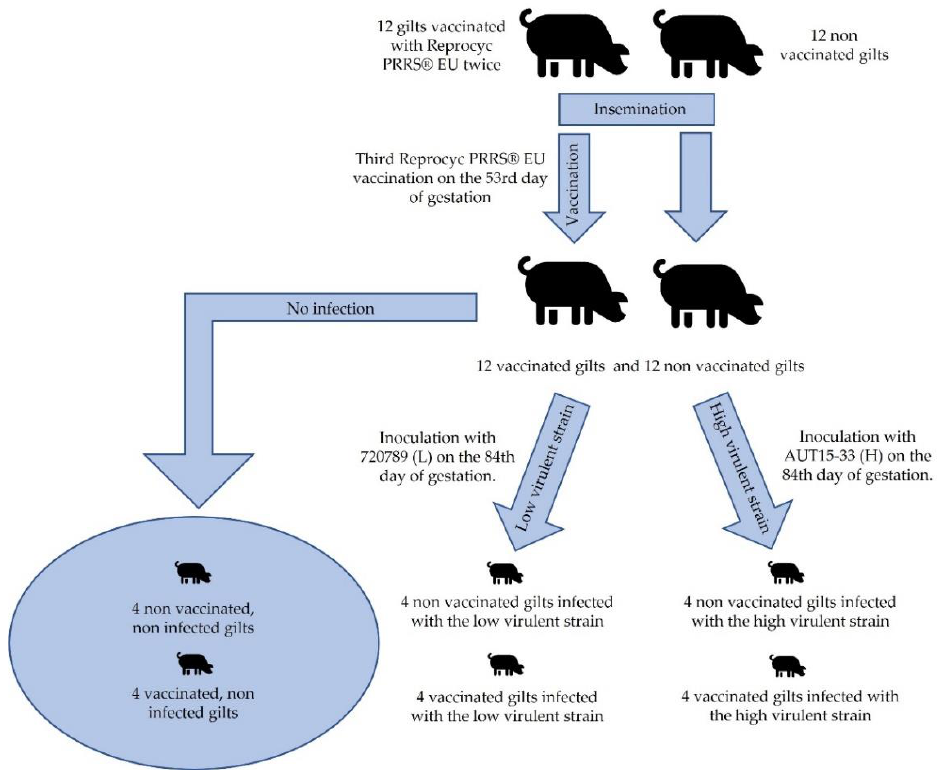
Figure 1. The simplified formation and distribution of the experimental groups.